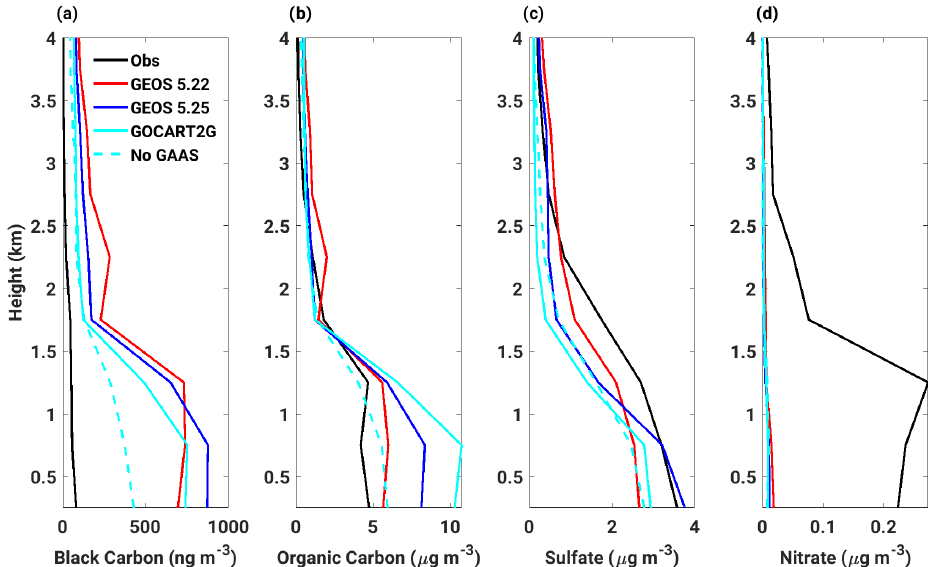
Figure 7. Mean vertical profile of aerosol mass concentration from the LARGE observations, GEOS 5.22, GEOS 5.25, GOCART2G, and GOCART2G without GAAS for (a) black carbon, (b) organic carbon, (c) sulfate, and (d) nitrate.